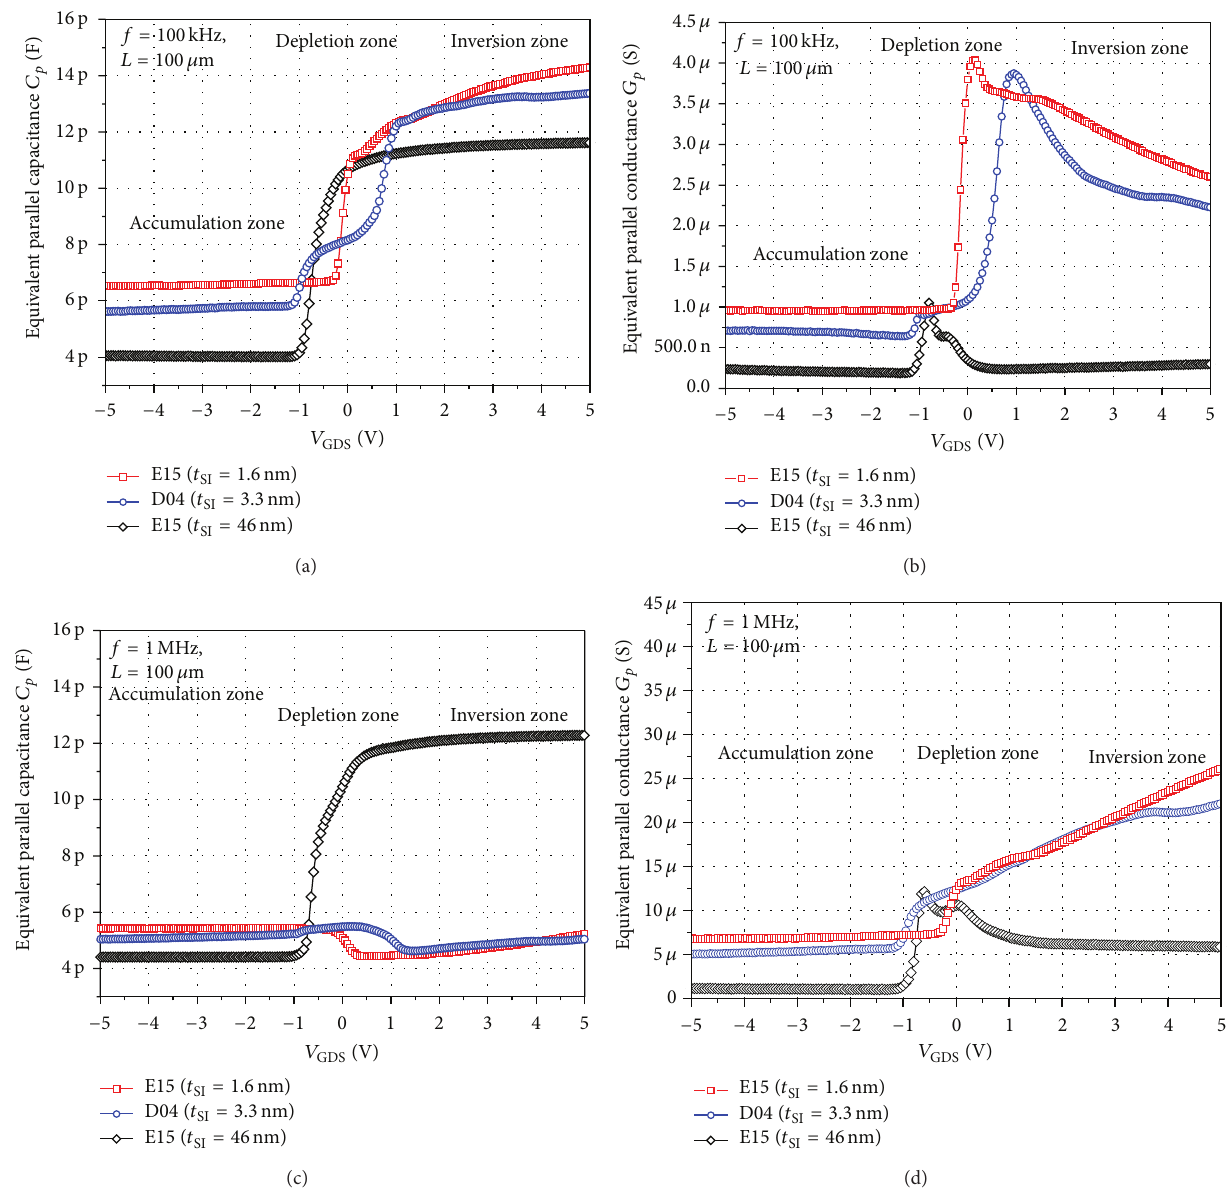
Figure 6: Parallel mode 𝐶 𝑝 - 𝑉 and 𝐺 𝑝 - 𝑉 characteristics for several channel thicknesses 𝑡 GDS GDS ( 80 × 100 𝜇 m 2 = 8 × 10 −5 cm 2 ). (a) Capacitance ( 𝐶 𝑝 ) measured at 100kHz. (b) Conductance (𝐺 𝑝 ) measured at 100kHz. (c) Capacitance ( 𝐶 𝑝 ) measured at 1MHz. (d) Conductance (𝐺 𝑝 ) measured at